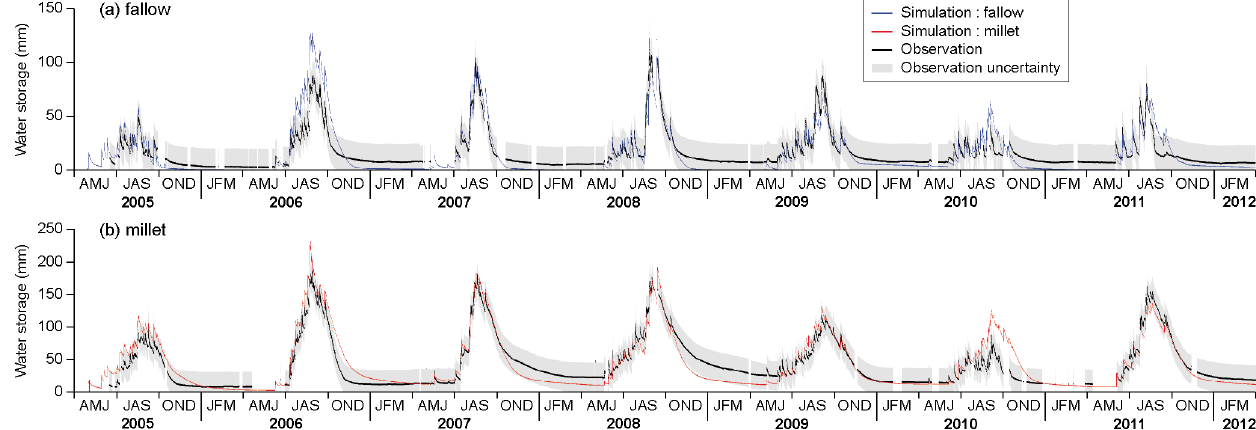
Figure B2. Observed and simulated courses of total water storage in the 0–2.5m soil layer at (a) fallow and (b) millet plots over 2005–2012 (storage taken above residual water content θ r